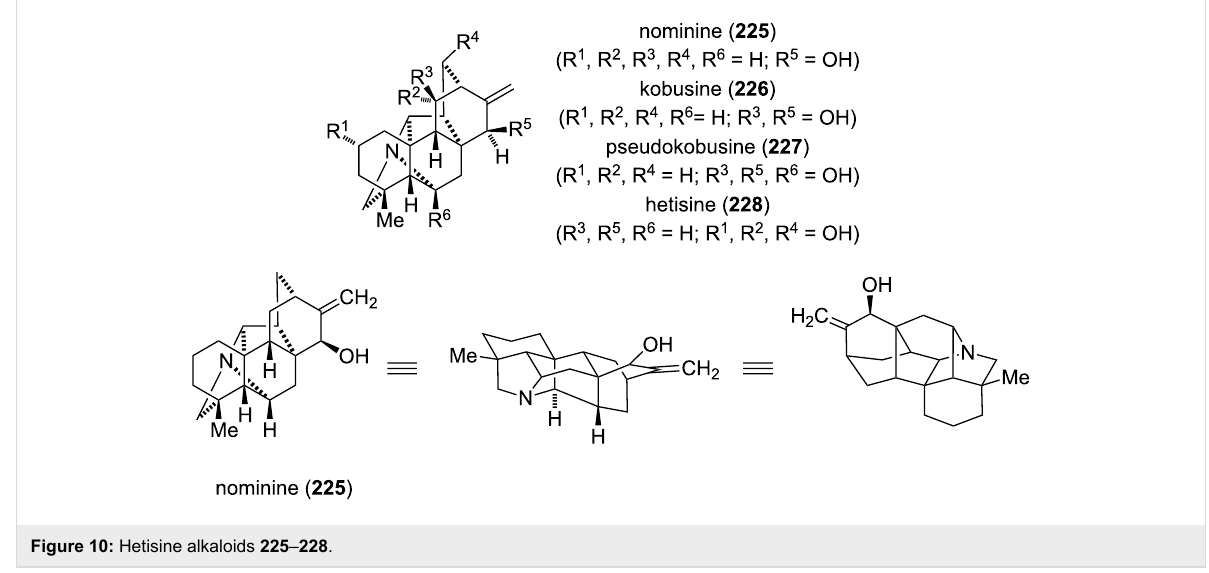
Figure 10: Hetisine alkaloids 225 – 228